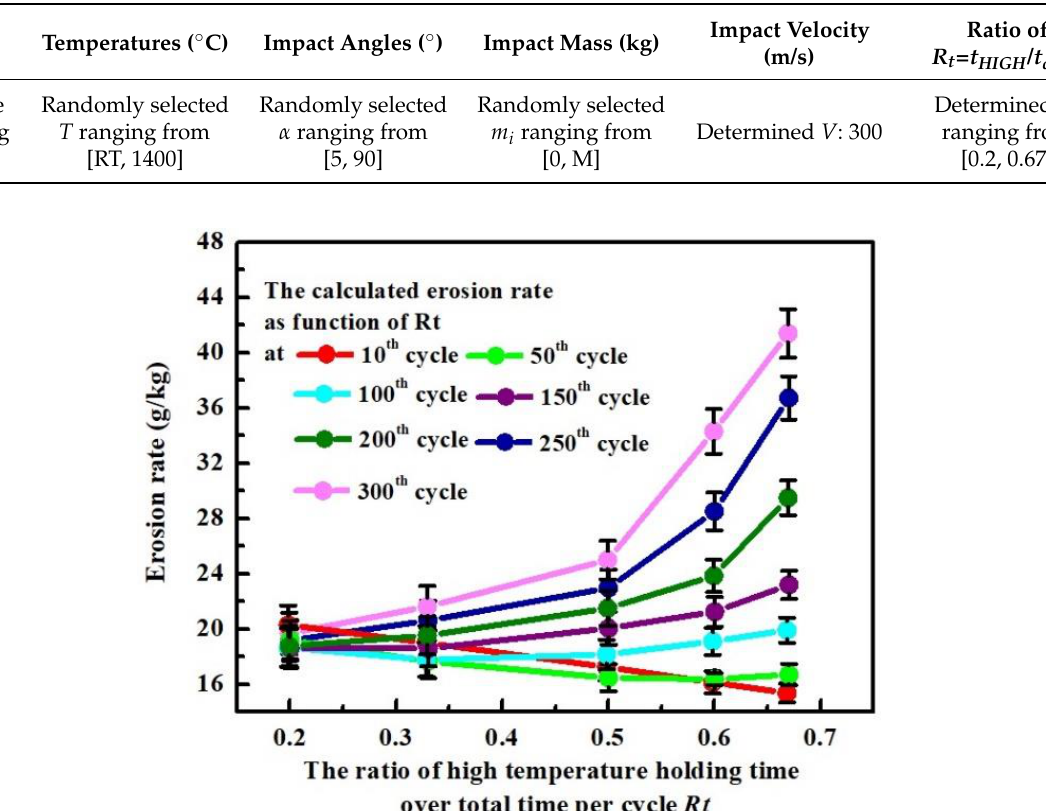
Table 9. Parameters used to calculate erosion rates at selected high-temperature dwell period.